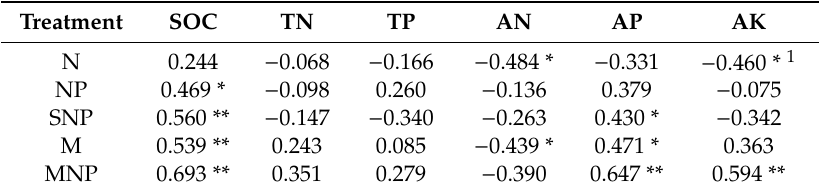
Figure 5. Relationship between contribution percentage of basic soil productivity of winter wheat and soil nutrient contents. ** and * are significance at the 0.01 and 0.05 level, respectively. Table 5. The correlation coe ffi cients between the contribution percentage of basic soil productivity (BSP) and soil